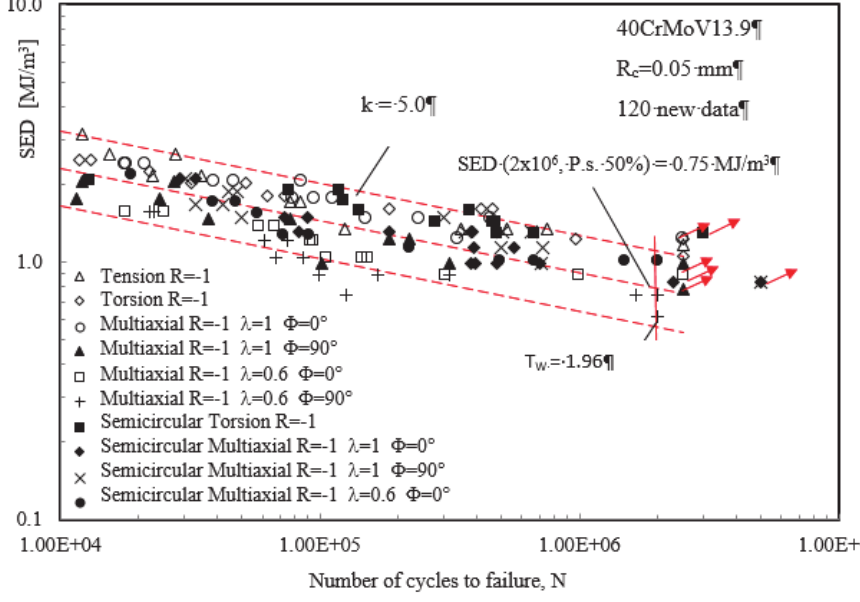
Figure 5: Synthesis by means of local SED of multiaxial series